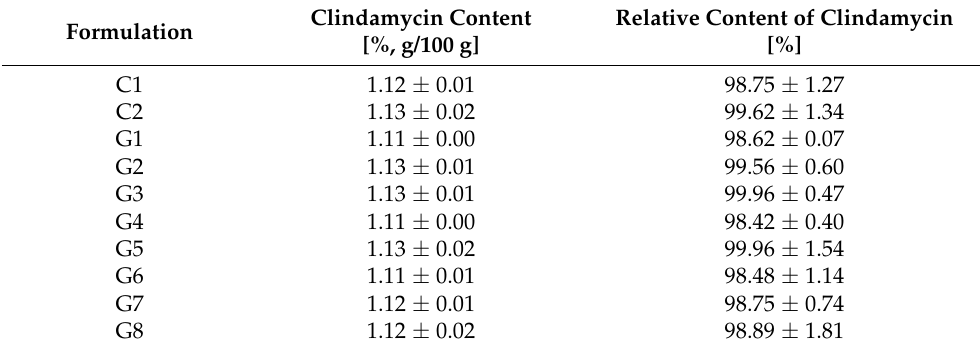
Table 2. Clindamycin content in hydrogel